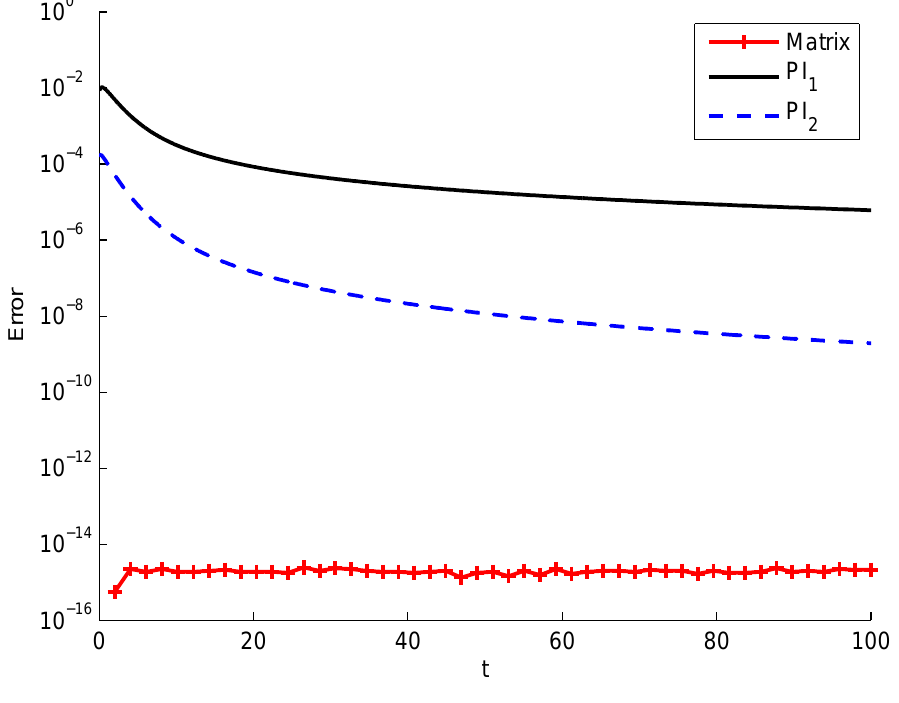
Figure 2. Error for the matrix approach and the product integration (PI) methods compared with the exact solution for α = 0.5 for the Basset equation.